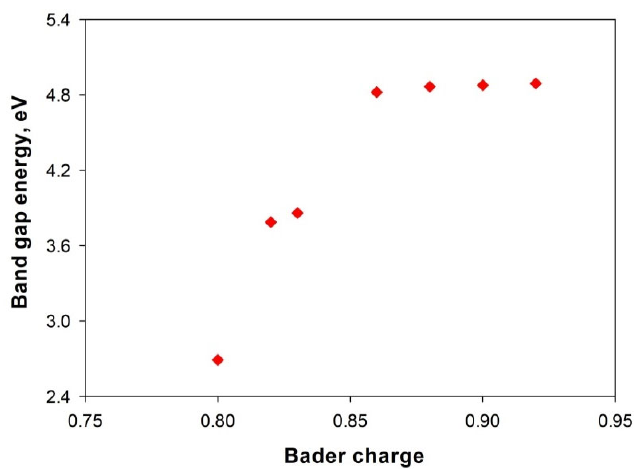
Figure 4. Bandgap energy of doped 2D Mg(OH) 2 with Bader charge of dopant. To render the 2D Mg(OH) 2 potential photocatalytic for water splitting, it must have decent band-edge positions for the redox potentials, where the CBM energy is higher than the reduction potential ( − 4.44 eV) of H + /H 2 , while the VBM energy is lower than the oxidation potential ( − 5.67 eV) of O 2 /H 2 O. When energy losses due to overpotential are counted, a much larger bandgap is usually needed for appreciable water splitting reac ‐ tion [56]. For the photocatalytic reduction of CO 2 , the required potential for CO 2 reduction to CH 3 OH is even higher ( − 0.38 V in comparison with 0 V of water at PH 7) [57]. Therefore, the bandgap energy for an excellent semiconductor photocatalyst is E g < 3.1 eV for visible light response [58]. Figure 5 shows the absolute band alignment of doped 2D Mg(OH) 2 in comparison with pristine 2D Mg(OH) 2 . It is seen that the CBM of all 2D Mg(OH) 2 are higher than the reduction potential of H + /H 2 , and also higher than the reduction potential of CO 2 , indicating that they are capable of the reduction reaction. Figure 5 indicates that VBM of pristine 2D Mg(OH) 2 is slightly larger than the oxidation potential of O 2 /H 2 O. This supports our observation that there is no direct application of 2D Mg(OH) 2 in photocatalytic water splitting without constructing vertical heterostruc ‐ tures with additional layered materials. VBM of F, Cl, SO 4 and PO 4 doped 2D Mg(OH) 2 moves downwards to lower energy due to the dopant’s contribution to the valence bands, and becomes lower than the oxidation potential of O 2 /H 2 O. This makes the doped 2D Mg(OH) 2 feasible to be applied for photocatalytic water splitting. Their bandgap is adversely higher than 3.1 eV for visible light response, with their bandgap being close to 4.80 eV of pristine 2D Mg(OH) 2 . Though it is encouraging that S, N, and P doping re ‐ markably reduces the bandgap of 2D Mg(OH) 2 , its VBM is moved upward to be over the oxidation potential of O 2 /H 2 O. These doped 2D Mg(OH) 2 cannot stand out as attractive candidates for photocatalytic water splitting applications. It is expected that S, N and P doping 2D Mg(OH) 2 will substantially improve the efficiencies of photocatalytic degra ‐ dation of organic dyes with the remarkably reduced bandgap and work function. It can even be inferred that a coupling doping of these anions may be a promising approach to achieve desirable bandgap and band alignment for photocatalytic water splitting. Therefore, our results establish a systematical methodology for the investigation of addi ‐ tional anion doping.